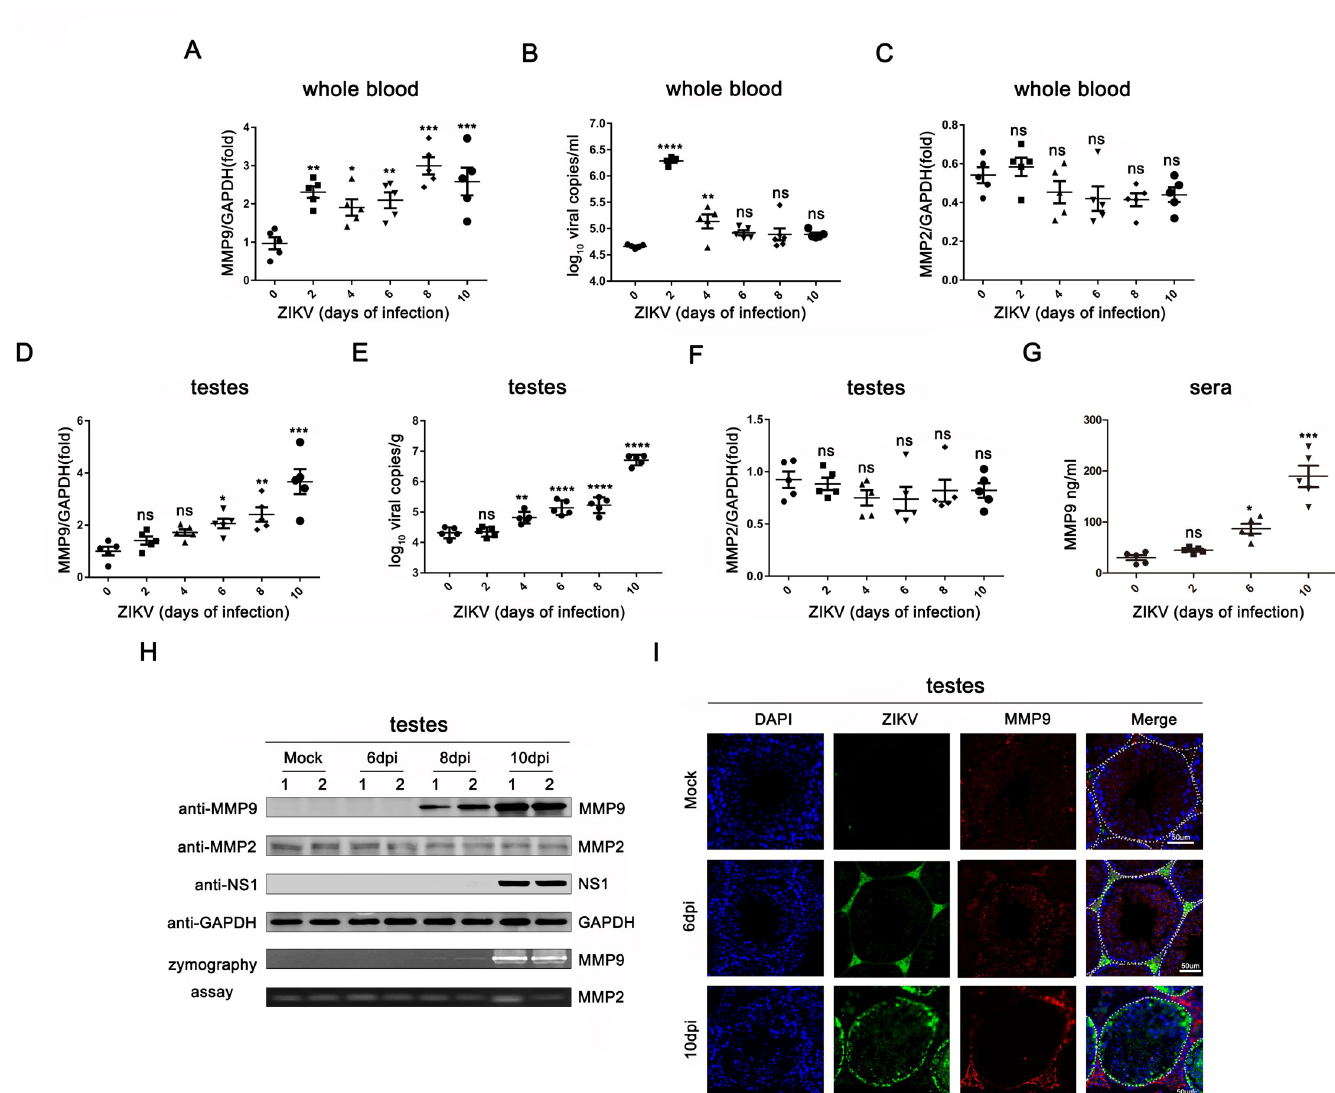
Fig 1. MMP9 was upregulated by ZIKV in vivo . A129 male mice (8 weeks old, n = 5) were infected with ZIKV (1 × 10 6 PFU) for 0, 2, 4, 6, 8, or 10 days. (A and C) MMP9 mRNA expression levels (A) and MMP2 mRNA expression levels (C) in the whole blood were measured by qRT-PCR and normalized to the GAPDH mRNA level. (B) A probe-based assay was used to quantify viral RNA copy number by TaqMan qPCR amplification of ZIKV E gene. (D and F) MMP9 mRNA expression levels (D) and MMP2 mRNA expression levels (F) in the testes were examined by qRT-PCR. (E) A probe-based assay was used to quantify viral RNA copy number by TaqMan qPCR amplification of ZIKV E gene. (G) Protein levels of MMP9 in the sera were tested by ELISA. Data are expressed as means ± SEMS of three independent experiments. � P < 0.05; � P < 0.01; ��� P < 0.001; ���� P < 0.0001. ns, not significant (one-way ANOVA). ( H ) Protein levels of MMP9, MMP2, NS1, GAPDH in the testes were quantified by western blotting (top), and proteinase activity was examined by gelatin zymography (bottom). Transparent bands indicate the presence of active MMP9 or MMP2. ( I ) Results of immunofluorescence staining. A129 mouse testis tissues were stained with DAPI to label nuclei (blue), an antibody against MMP9 (red), and ZIKV-positive signals (green) were detected by Z6 antibodies. Representatives of the tubules within the seminiferous epithelium are indicated with white dotted lines. Scale bar, 50 μ m. strong ZIKV positive signals were found in the interstitium, and much weaker but still detect- able signals were found inside the seminiferous tubules, and the expression of MMP9 was slightly increased. Because ZIKV continuously replicated and spread in the testes, the virus sig- nal was significantly higher at day 10, consistent with the increase in MMP9 staining. Moreover,